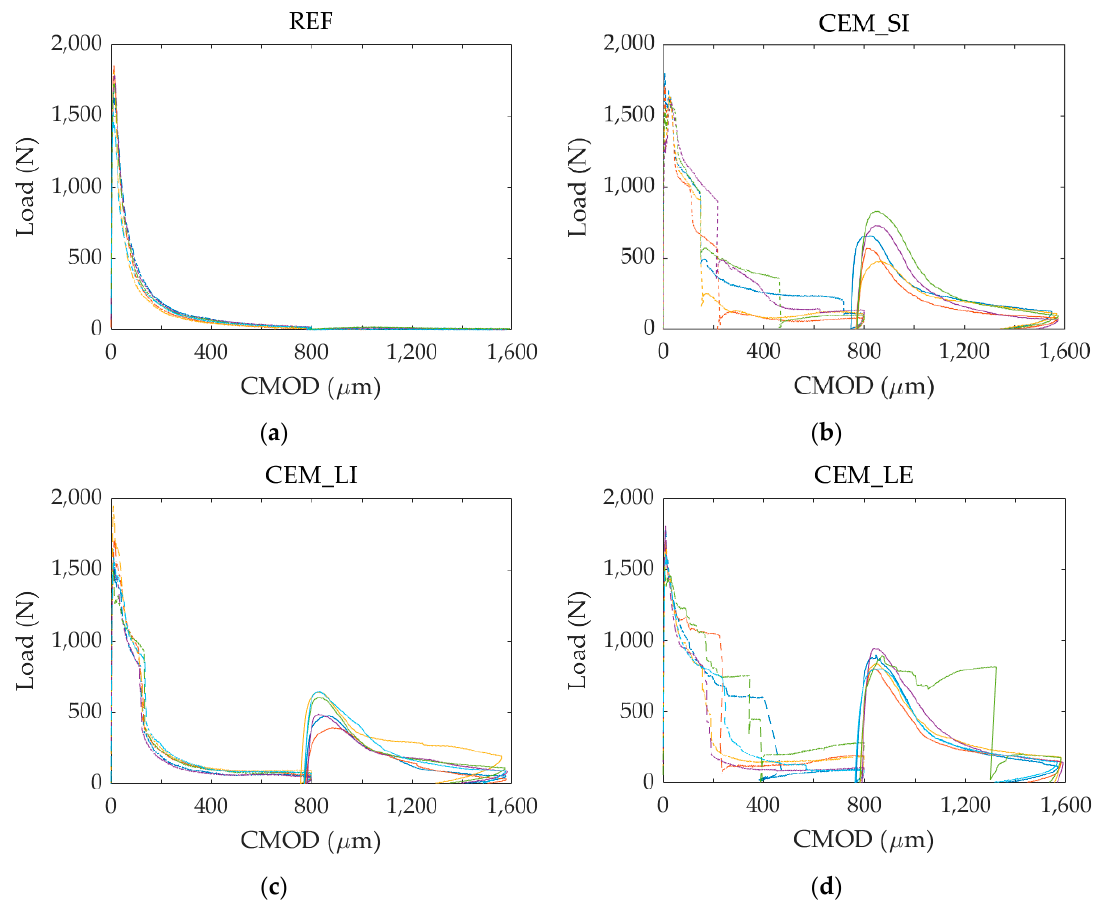
Figure 10. Load versus CMOD curves during the pre-cracking (dashed line) and the subsequent static reloading (continuous line) for the di ff erent series: ( a ) REF series; ( b ) CEM_SI series; ( c ) CEM_LI series; ( d ) CEM_LE series. The specimens are distinguished by di ff erent colour